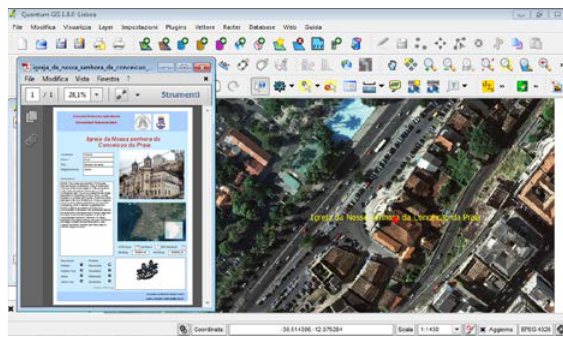
Figure 9. Hyperlink action to retrieve the data sheet in the GIS database